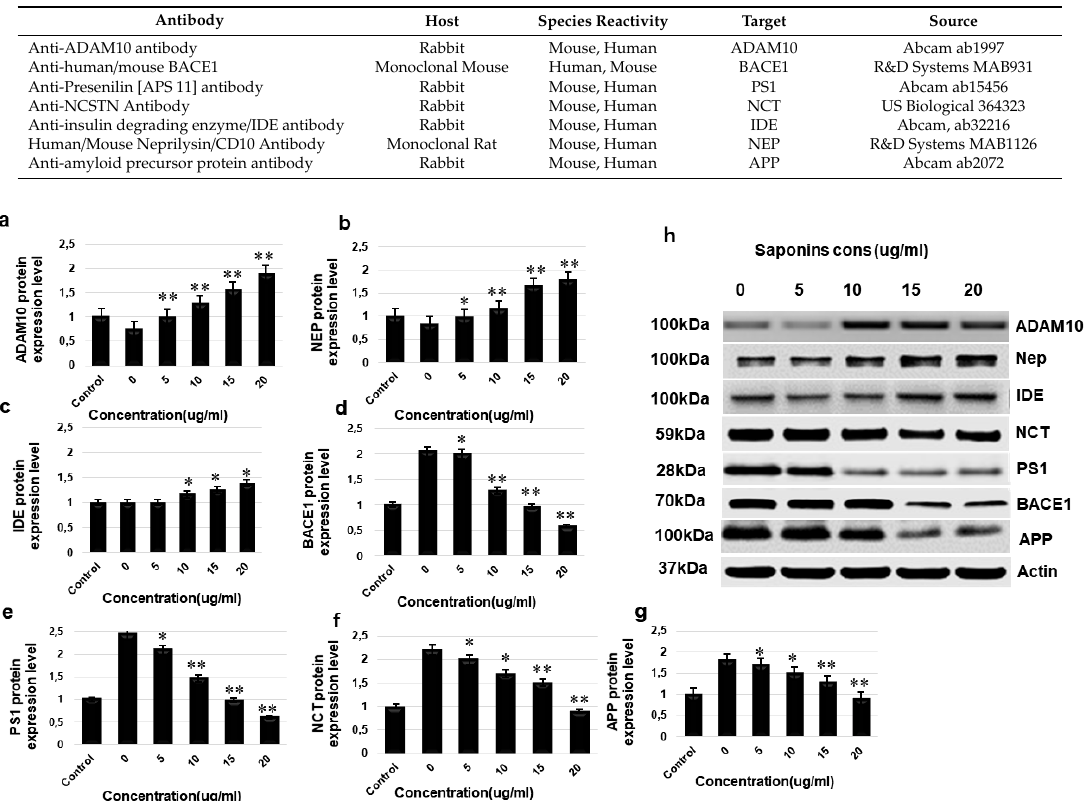
Figure 8. Effects of theasaponin E1 on the protein expression level of ADAM10, BACE1, PS1, NCT, neprlysin, IDE and APP determined by western blotting. Relative proteins expression levels of various proteins normalized (fold change) to control ( β -actin). ( a ) Relative proteins expression level of α -secretase (ADAM10). ( b ) Relative proteins expression level of neprilysin. ( c ) Relative proteins expression level of insulin degrading enzyme (IDE). ( d ) Relative proteins expression level of β -secretase ( BACE1 ). ( e ) Relative proteins expression level of γ -secretase presenilin 1 ( PS1 ). ( f ) Relative proteins expression level of γ -secretase nicastrin NCT . ( g ) Relative expression level of APP . ( h ) Expression of APP, ADAM10, BACE1, PS1, NCT, neprilysin and IDE proteins, visualized bands on membrane. Data are expressed as mean ± SEM. Data were analysed with one-way ANOVA ( n = 3). Data are statistically significant at p < 0.05. (* p < 0.05; ** p < 0.01). Data are expressed as mean ± SEM.